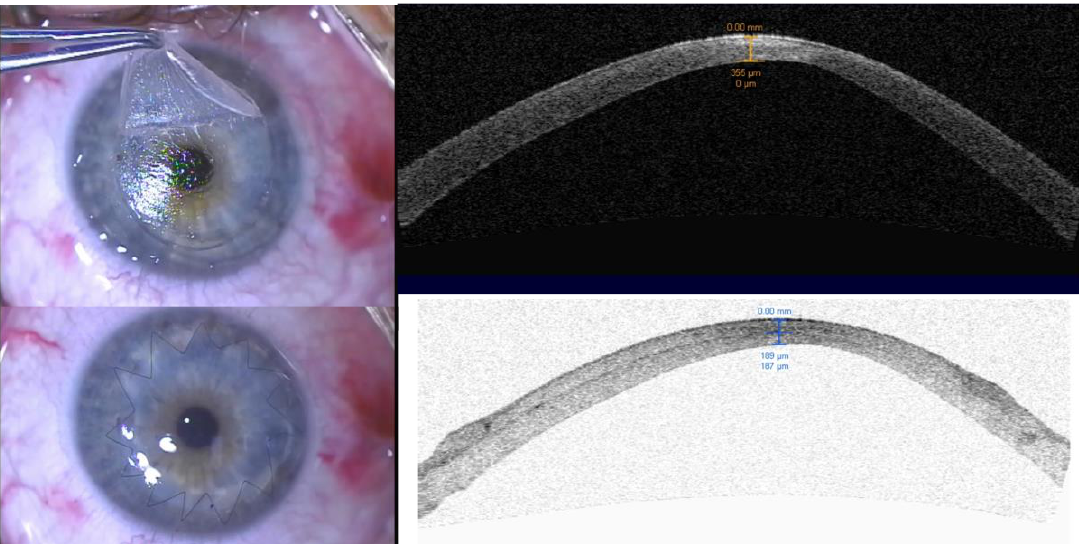
Figure 2. Clinical photography and the anterior segment OCT of the 44 year old female, with initial BCVA of 0.2 and 12 months post op of 0.8. The top right panel of the figure shows the clinical photography of the patient ’ s eyes during the surgery with the host flap create by the laser. The bottom left image shows the postoperative appearance of the eye with the single continuous suture. The top right panel of the figure shows the corresponding anterior segment OCT images of the patient ’ s eyes, which reveals the thinning of the central cornea and the irregularity of the corneal surface. The bottom right image shows the postoperative anterior segment OCT, which reveals the presence of a donor/host interface and a larger corneal thickness.